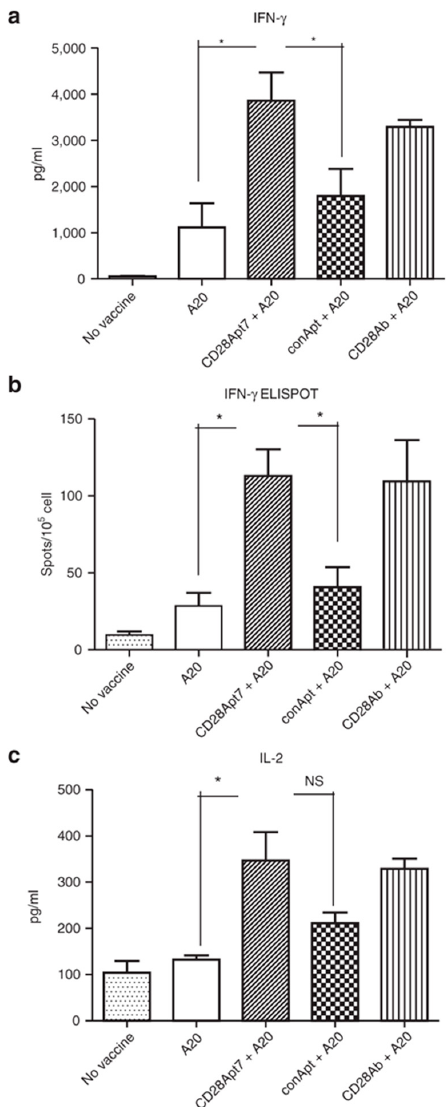
Figure 1. Boosting cellular immune response through the CD28Apt7 dimer. ( a ) Detection of IFN- γ by Enzyme-Linked ImmunoSorbent Assay (ELISA) from supernatant obtained after a 48 h co-culture of irradiated A20 cells and lymphocytes obtained from mice previously immunized with irradiated A20 cells plus 400 pmol of the CD28Apt7 dimer, or CD28 agonistic antibody 37.51, or a scramble aptamer. The results are expressed as mean and SEM of triplicate experiments; ( b ) Detection of IFN- γ -producing lymphocytes through Enzyme-Linked ImmunoSpot Assay (ELISpot) after 24 h co-culture of irradiated A20 cells and lymphocytes obtained from mice previously immunized with irradiated A20 cells plus 400 pmol of the CD28Apt7 dimer, or CD28 agonistic antibody 37.51, or a scramble aptamer. The results are expressed as mean and SEM of triplicate experiments; ( c ) Detection of IL-2 by ELISA from supernatant obtained after a 48 h co-culture of irradiated A20 cells and lymphocytes obtained from mice previously immunized with irradiated A20 cells plus 400 pmol of the CD28Apt7 dimer, or CD28 agonistic antibody 37.51, or a scramble aptamer. The results are expressed as mean and SEM of triplicate experiments. * p < 0.05. IFN, interferon; IL, interleukin; NS, not significant. Reproduced from Pastor et al.